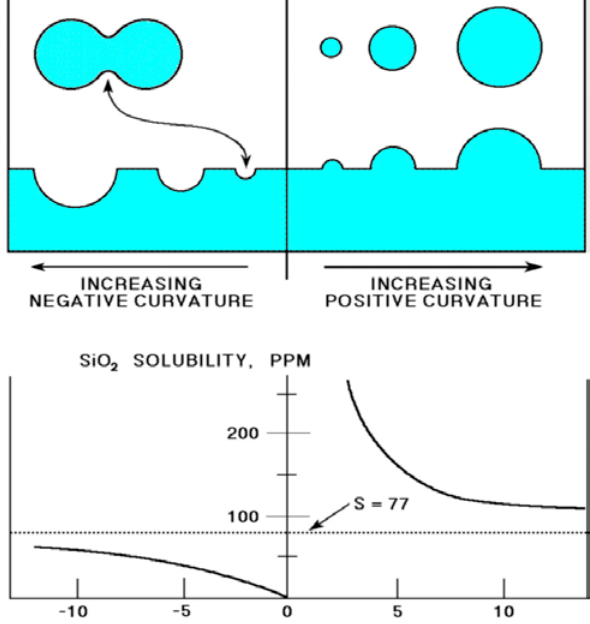
Figure 53, The solubility of silica varies inversely with the radius of curvature of the surface according to the Ostwald-Freundlich equa- tion. The positive radii of curvature are shown as cross-sections of particles and as projections from a silica surface. Negative cur- vatures are shown as depressions or holes in a silica surface or in the crevice between two adhering particles. The solubility in ppm is indicated in the lower diagram. Two important practical effects